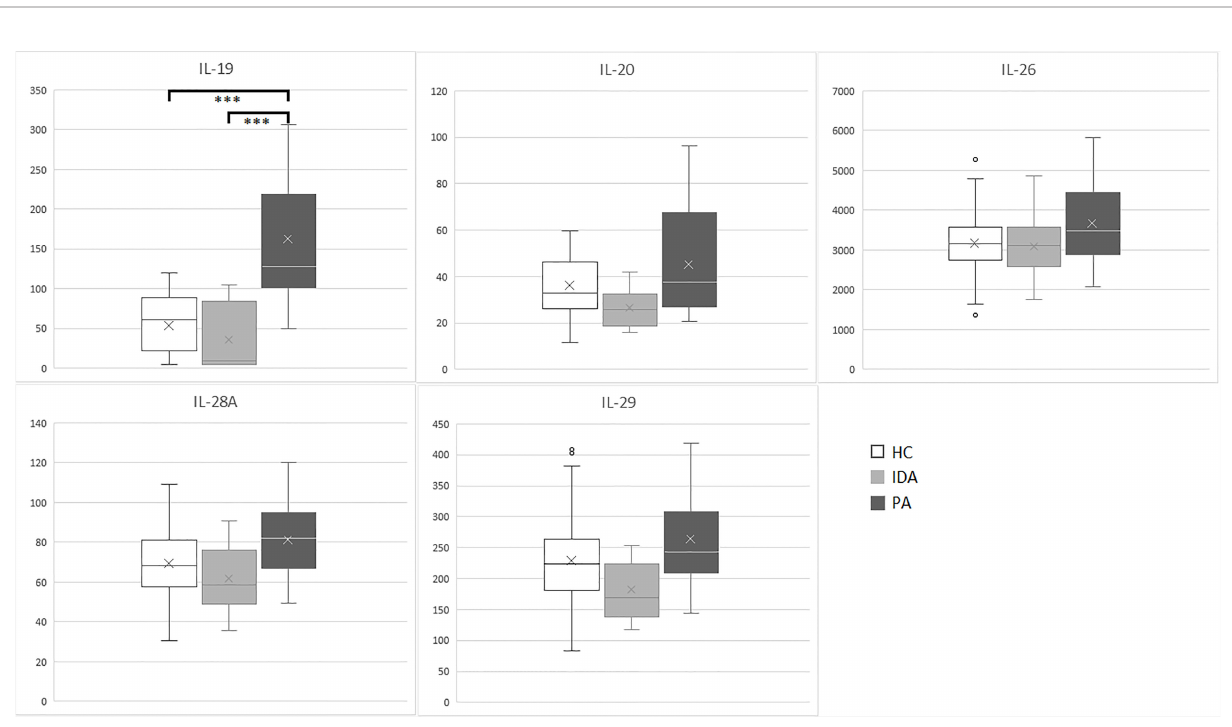
IL-19 Production by Lamina Propria Mononuclear Cells Derived From the Gastric Mucosa of Patients With Pernicious Anemia On the basis of results obtained at serum level, we then asked whether IL-19 is produced in vivo by patients with PA and autoimmune gastritis. Since gastric mucosal involvement was